Question: Briefly state, in one sentence, what is plotted here.
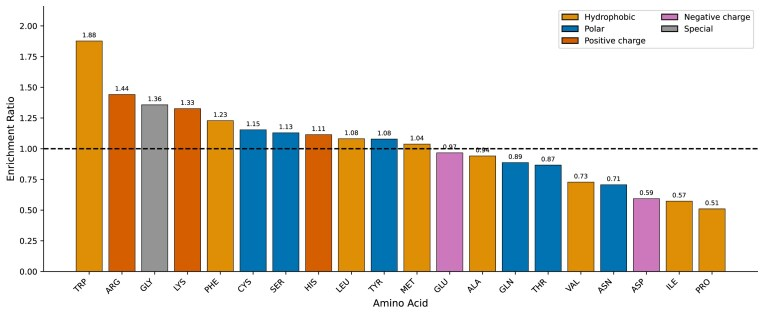
Answer: Amino acid enrichment at lipid contact sites. Enrichment ratios are calculated as the frequency of each amino acid among contact residues divided by its overall frequency in the dataset. Bars are grouped by physicochemical class, as indicated in the legend: hydrophobic, polar, positively charged, negatively charged, and special. The dashed line marks the expected frequency (1.0). Values above 1.0 indicate enrichment; values below 1.0 indicate depletion.